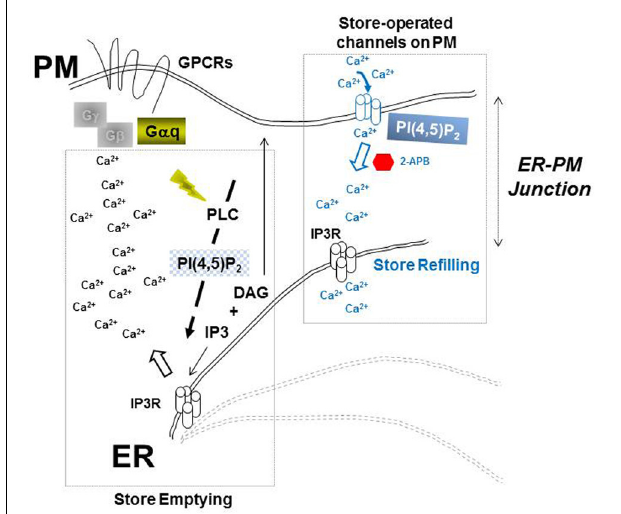
FIGURE 1 | PI(4,5)P 2 -dependent Ca 2 + machinery. Ca 2 + store emptying ( left ) and store re-filling ( right ) at dynamic ER-PM junctions (dashed lines) are highlighted as key events of IP3R-gating at the prototypical Ca 2 + store in the